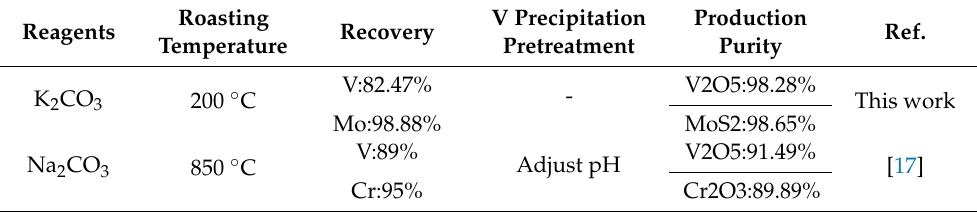
Figure 15. Quantity–quality flowsheet of the recovered vanadium and molybdenum. Table 4. Process parameters of treating HCVR with different roasting reagent.